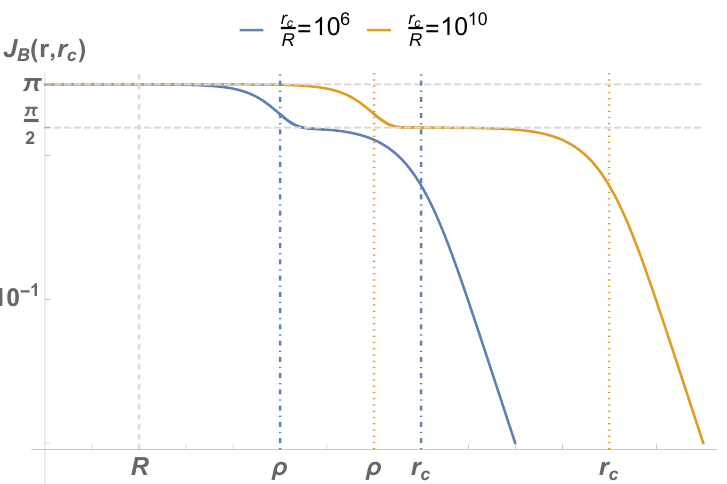
Figure 9. This log-log plot shows the numerical value of J B as a function of r (in units of R ) for two di(cid:11)erent values of r c =R as solid curves. The blue curve is plotted for r c =R = 10 6 and the orange one for r c =R = 10 10 . The dashed horizontal lines go through the points (cid:25) and (cid:25)= 2. We see that J B starts with a constant value of (cid:25) for r (cid:28) (cid:26) , does not change across R and then crosses over to a DGP-behavior at r (cid:24) (cid:26) , where it goes from a constant value of (cid:25)= 2 to a 1 the constant region ( (cid:25)= 2) is more pronounced for larger values of r c =R . The vertical lines show the scales, which separate the regimes, stated in section